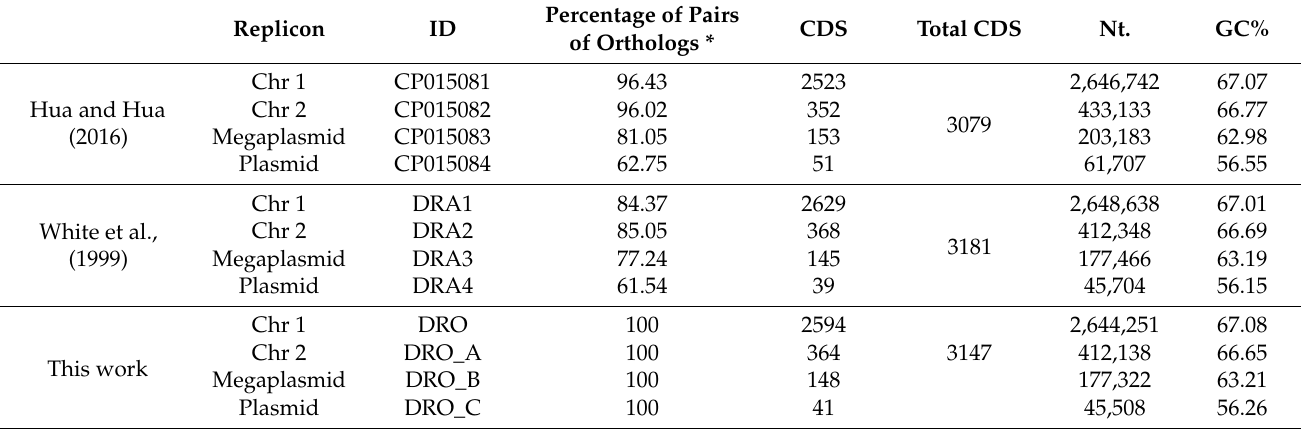
Table 1. Size of each replicon, %GC, and CDS content in Deinococcus radiodurans strain R1 ATCC 13939 genome sequence. Percentage of pairs of orthologs found in the genome sequence of our strain when compared to the two other strains’ R1 genome sequence when a threshold of 90% of maximum bit score was